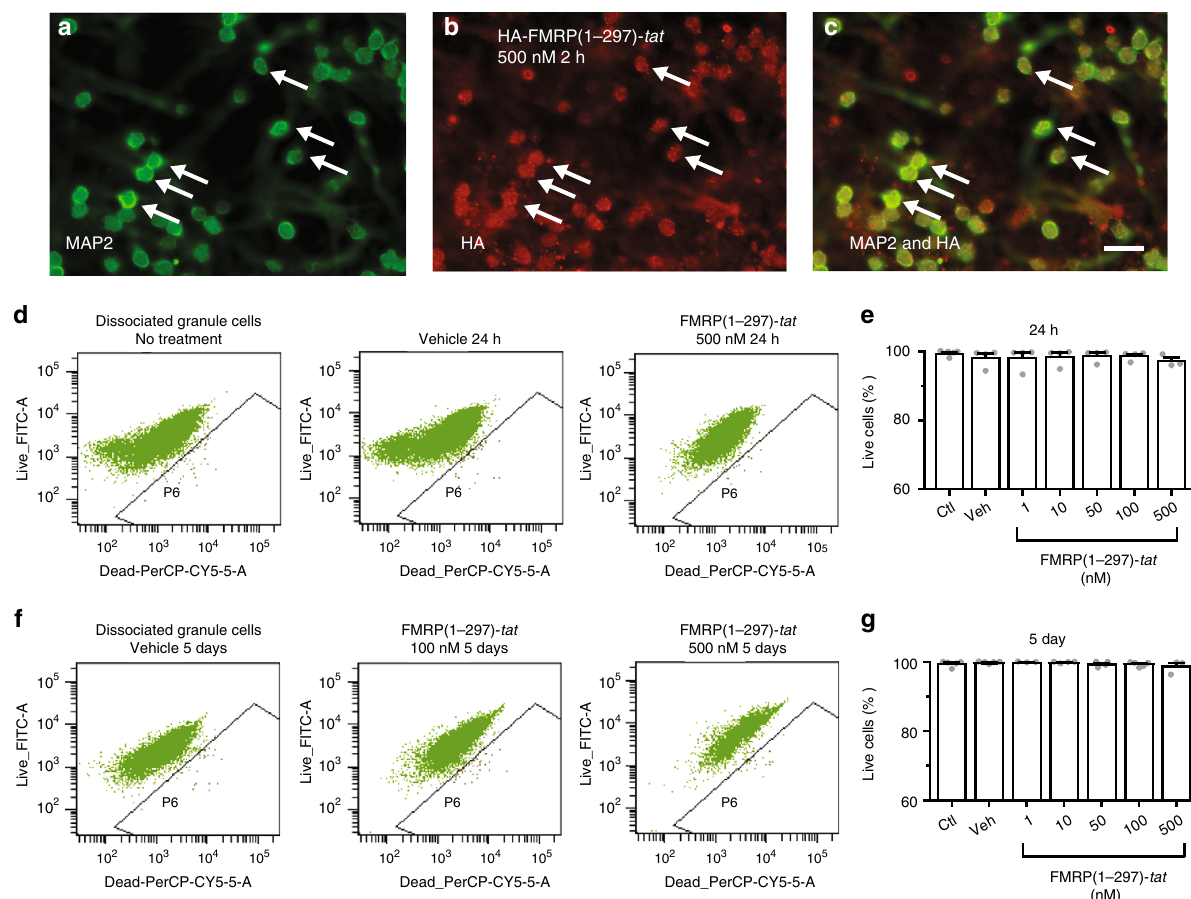
Fig. 6 FMRP(1 – 297)- tat is non-toxic to cultured Fmr1 KO granule cells. a – c Images of dual immunolabeled dissociated cultures of Fmr1 KO granule cells at 3 DIV for MAP2 and an anti-HA antibody 2 h following direct exposure to 500 nM (equivalent to 1.0 mg/kg in situ) HA-FMRP(1-297)- tat . Arrows denote position of representative cells labeling for both MAP2 and HA. Immunostaining was repeated with 3 different batches of cerebellar granule cell cultures. Scale bar, 25 µ m. d – g Flow cytometric analysis of a live-dead cell viability assay in cerebellar granule cell cultures 24 h ( d , e ) and 5 days ( f , g ) after single exposure to the indicated concentrations of FMRP(1 – 297)- tat . The percentage of live cells in each cell population is not signi fi cantly different among the control group with no treatment, the vehicle treated group and cell groups treated with FMRP(1 – 297)- tat for 24 h (control, 99.4 ± 0.4%, n = 5; vehicle, 99.6 ± 0.2%, n = 5; 1 nM, 99.7 ± 0.1%, n = 3; 10 nM, 99.7 ± 0.1%, n = 4; 50 nM, 99.2 ± 0.4%, n = 4; 100 nM, 99.3 ± 0.3%, n = 5; 500 nM, 98.6 ± 1.1%, n = 3; F (6,28) = 0.763, p = 0.607, one-way ANOVA) and at 5 days (vehicle, 98.2 ± 1.3%, n = 4; 1 nM, 98.1 ± 1.6%, n = 4; 10 nM, 98.5 ± 1.2%, n = 4; 50 nM, 98.8 ± 0.9%, n = 4; 100 nM, 98.7 ± 0.6%, n = 4; 500 nM, 97.2 ± 1.0%, n = 3; F (6,27) = 0.406, p = 0.867, one-way ANOVA). N value represents